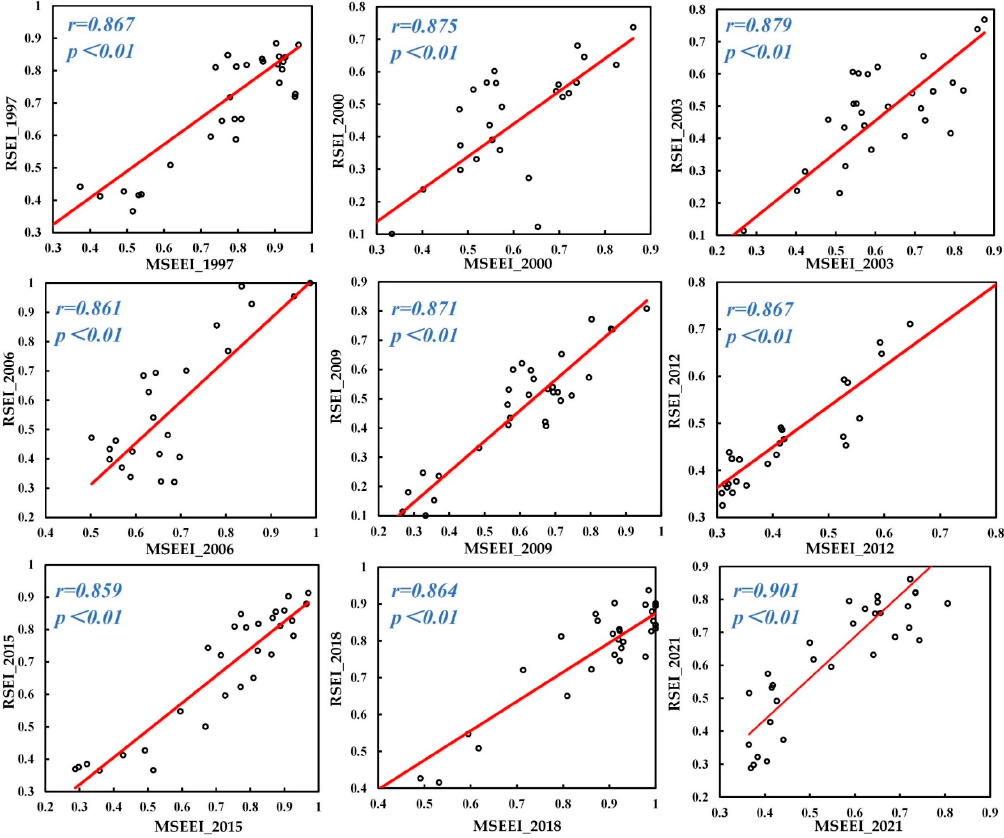
Figure 4. Correlations between the MSEEI and RSEI in 1997, 2000, 2003, 2006, 2009, 2012, 2015, 2018, and 2021. Table 1. Mean correlations of the MSEEI and